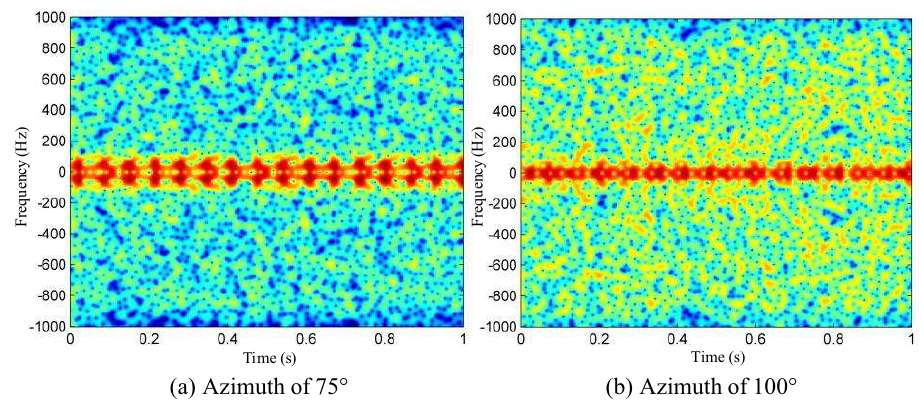
Figure 4. Micro-Doppler signature of drones at different azimuth